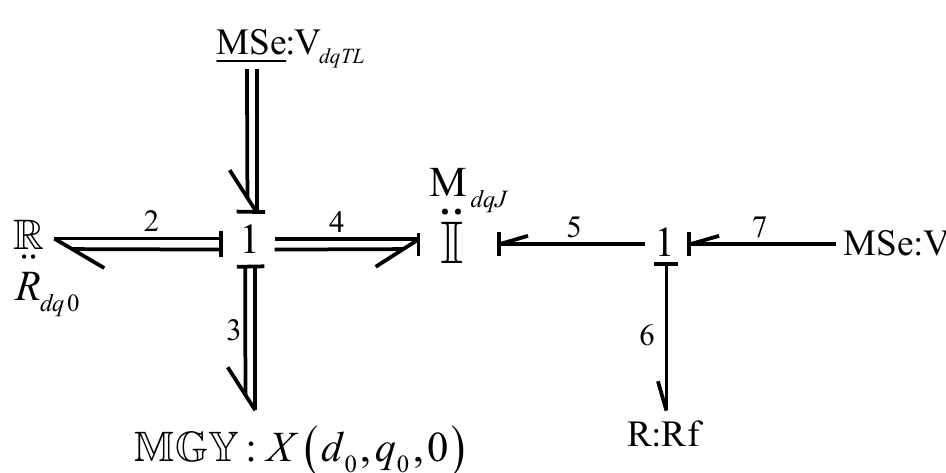
Figure 18. Multibond graph of a synchronous